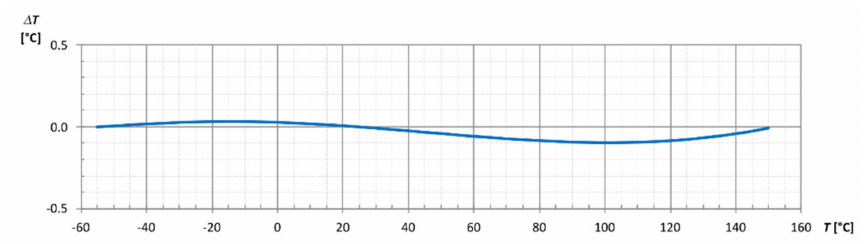
Figure 13. Temperature error for Steinhart–Hart equation-based expression.